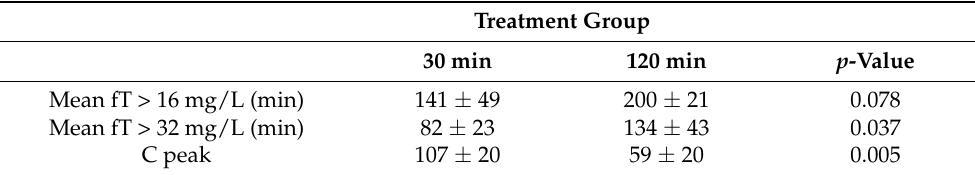
Table 2. Comparison of fT > MIC and peak concentrations between groups. Treatment Group